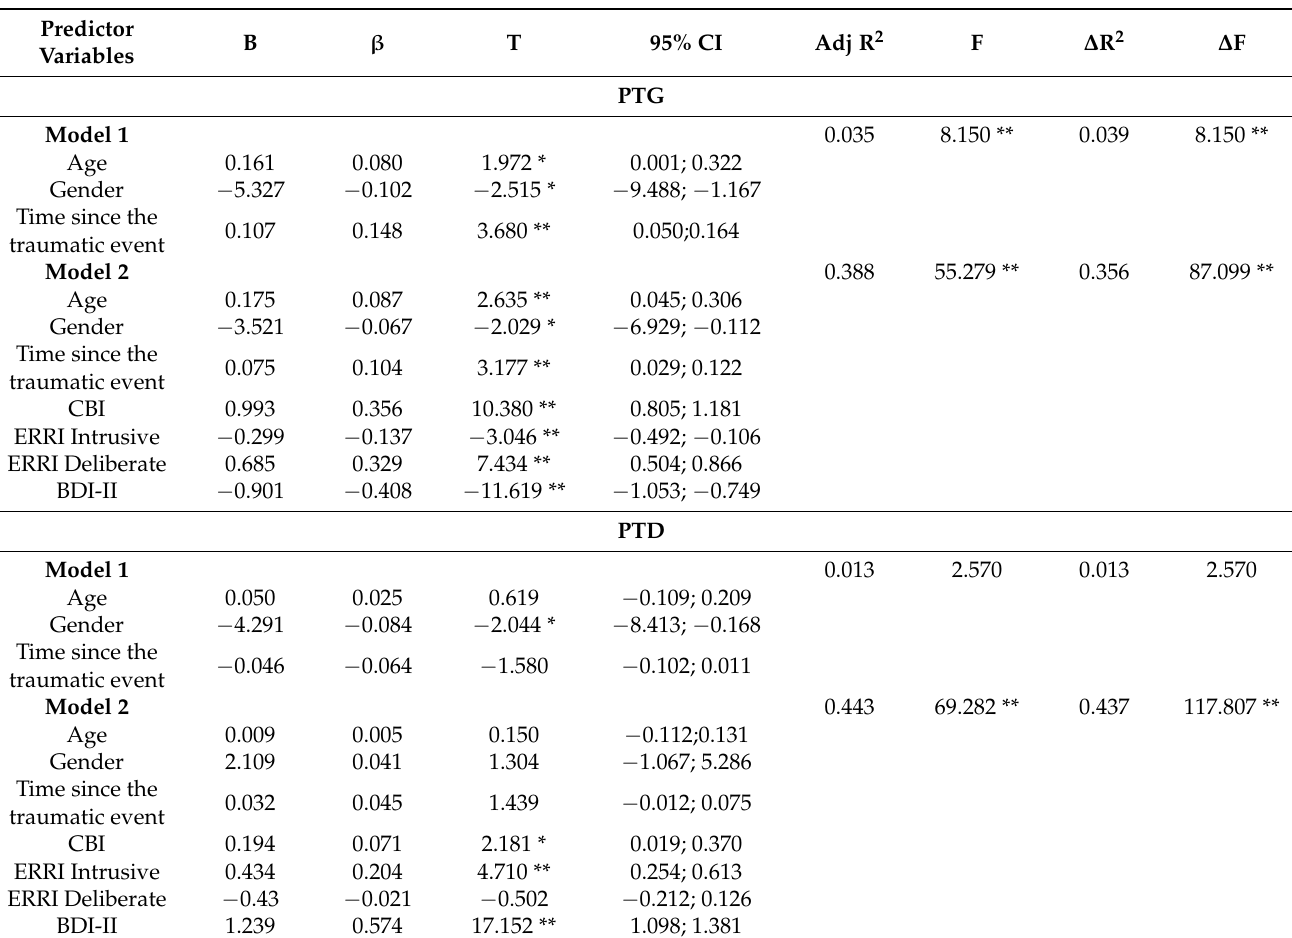
Table 2. Hierarchical multiple regressions predicting PTG and PTD scores from sociodemographic and trauma- related variables, core beliefs, intrusive and deliberate rumination, and depressive symptoms ( n =